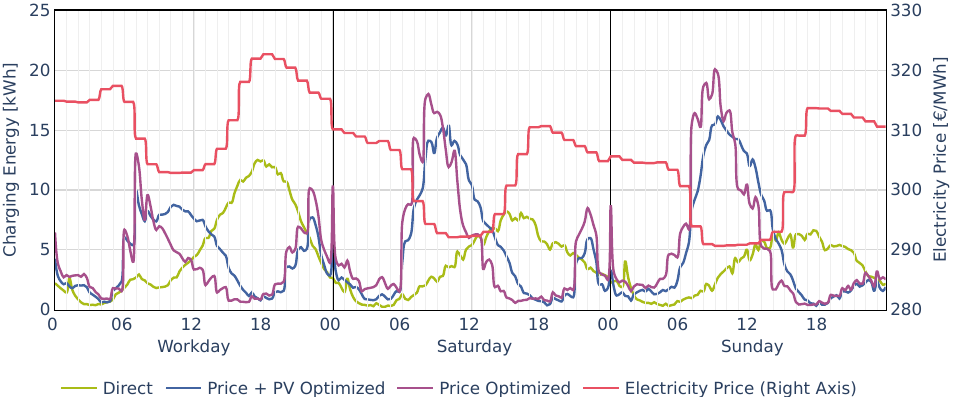
Figure 12. Aggregated average for EV charging energy and corresponding electricity price on different type days: “direct charging”, “price optimized charging” and “combined price + PV optimized charging”.